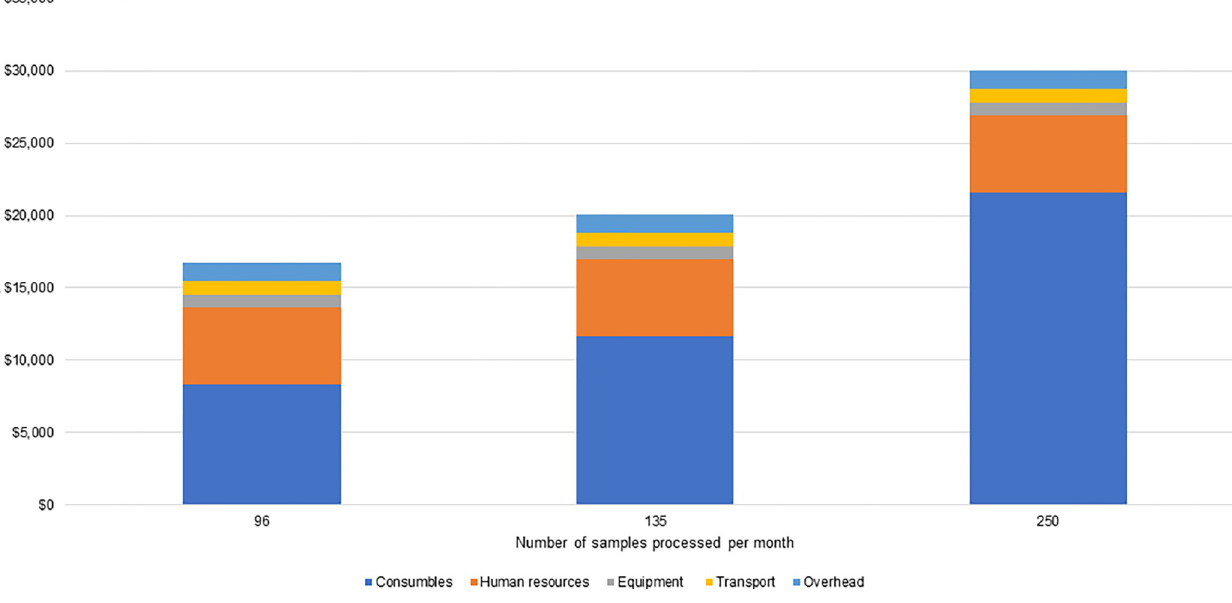
PLOS Global PublicHealth | https://doi.org/10.1371/journal.pgph.0001377 December 27,